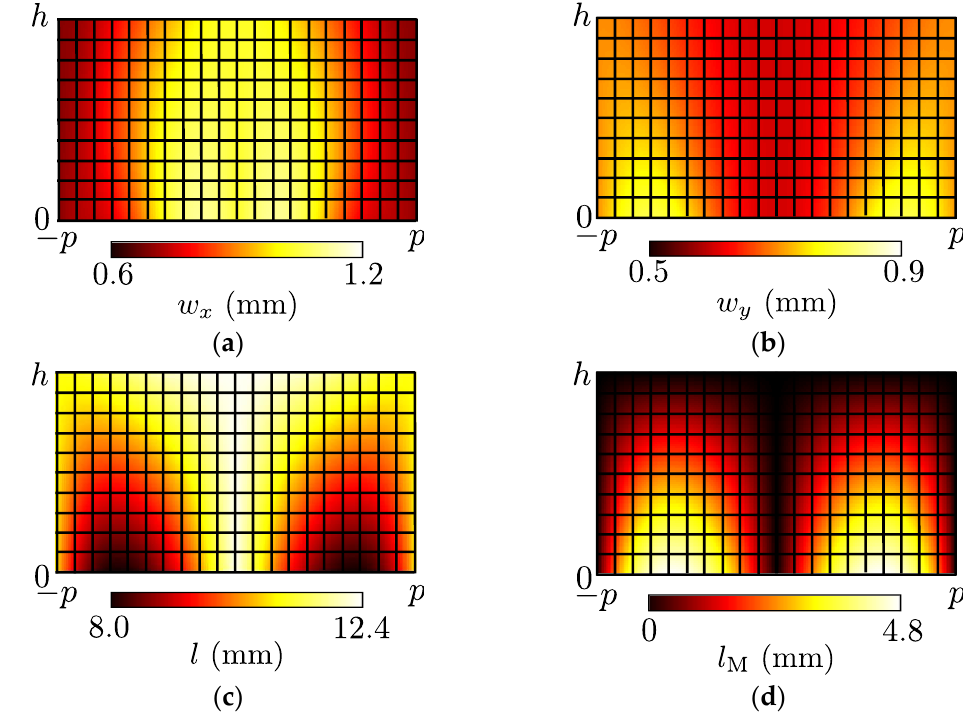
Figure 9. Calculated results of the waveguide widths and lengths for the acoustic illusion medium